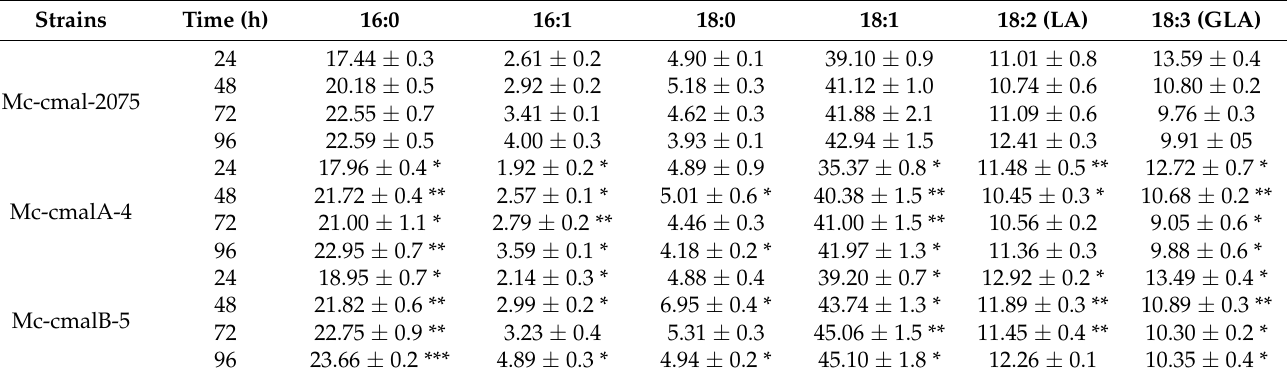
Table 1. Composition of fatty acids (%, w / w of total fatty acids) * in Mc-cmal- 2075, Mc-cmalA-4, and Mc-cmalB-5 strains.